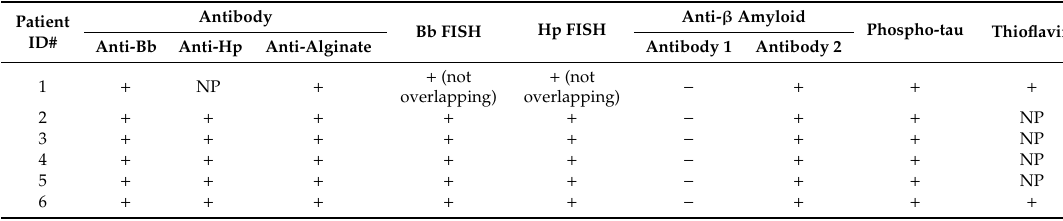
Table 7. Summary of histochemical staining. NP, not